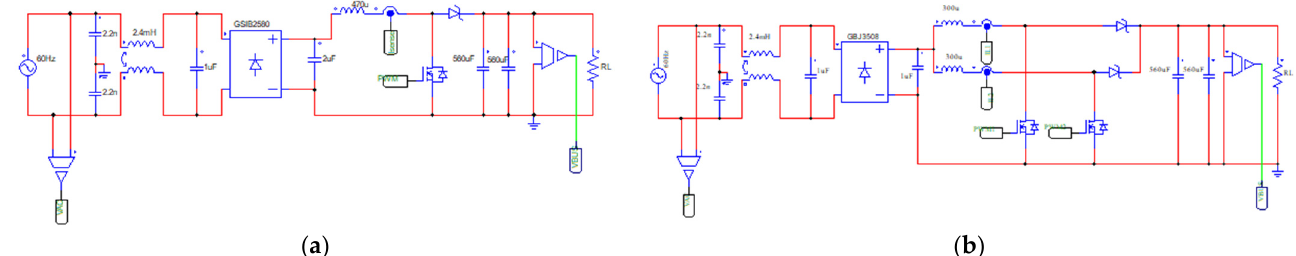
Figure 13. PSIM simulation circuit for the PFC topologies: ( a ) conventional boost PFC; ( b ) interleaved boost PFC.